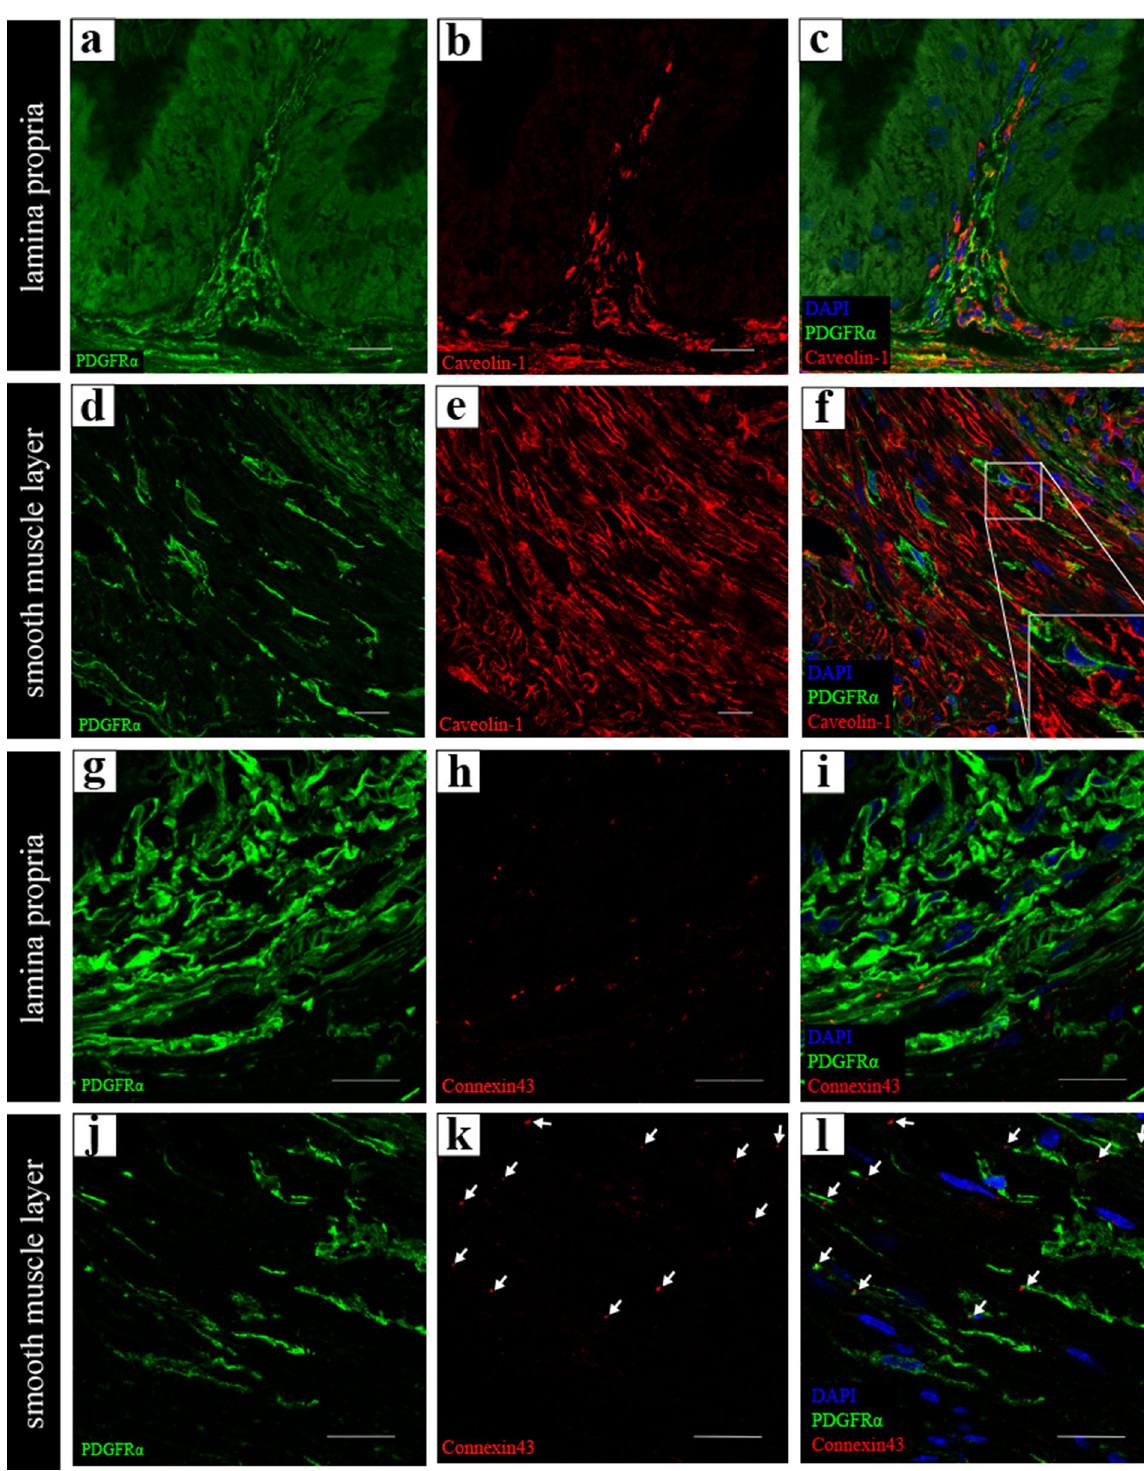
Figure 4. ( a – e ) Representative images of the double immunolabeling for PDGFRα (green) and caveolin-1 (red) in the lamina propria ( a – c ) and in the smooth muscle layer ( b – e ). PDGFRα-immunoreactivity (IR) was partially co-labeled with caveolin-1-IR in all layers ( c , f ). High magnification in the white line square area (inset at the lower right corner of ( f )). ( g – l ) Representative images of the double immunolabeling for PDGFRα (green) and connexin-43 (red) in the lamina propria ( g – i ) and in the smooth muscle layer ( j – l ). Connexin 43-IR was observed surrounding PDGFRα-IR in the lamina propria ( i ). However, Connexin 43-IR (white arrows) was less prominent in the smooth muscle layer than in the lamina propria ( l ). Nuclei were counterstained in blue with 4 ′ ,6-diamidino-2-phenylindole ( c , f , i , l ). Scale bars: 20 µm ( a – l ), 5 µm (inset at the lower right corner of ( f